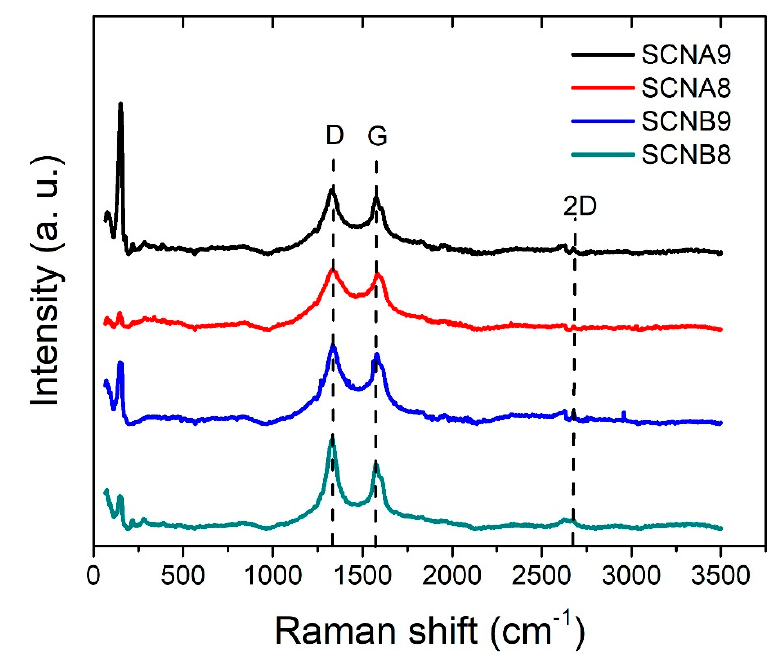
Figure 6. Raman spectra of sulfur-added carbon nanostructures synthesized at different temperatures and carrier gas flow rates.